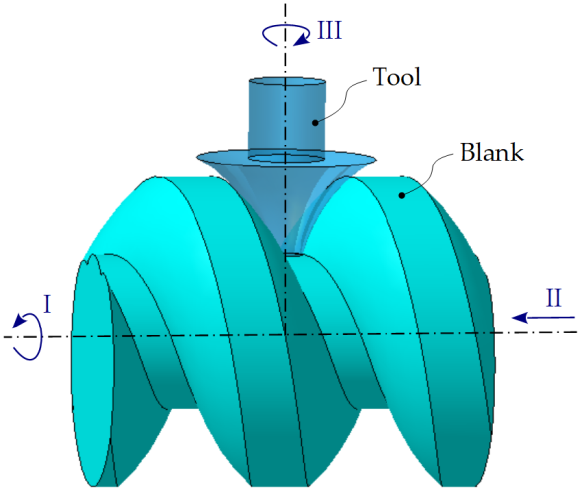
Figure 18. Kinematic principle. Movement I represents the rotation of the blank around its own axis. This is corre- lated with the translational movement II , along the same axis, to ensure the helical movement.